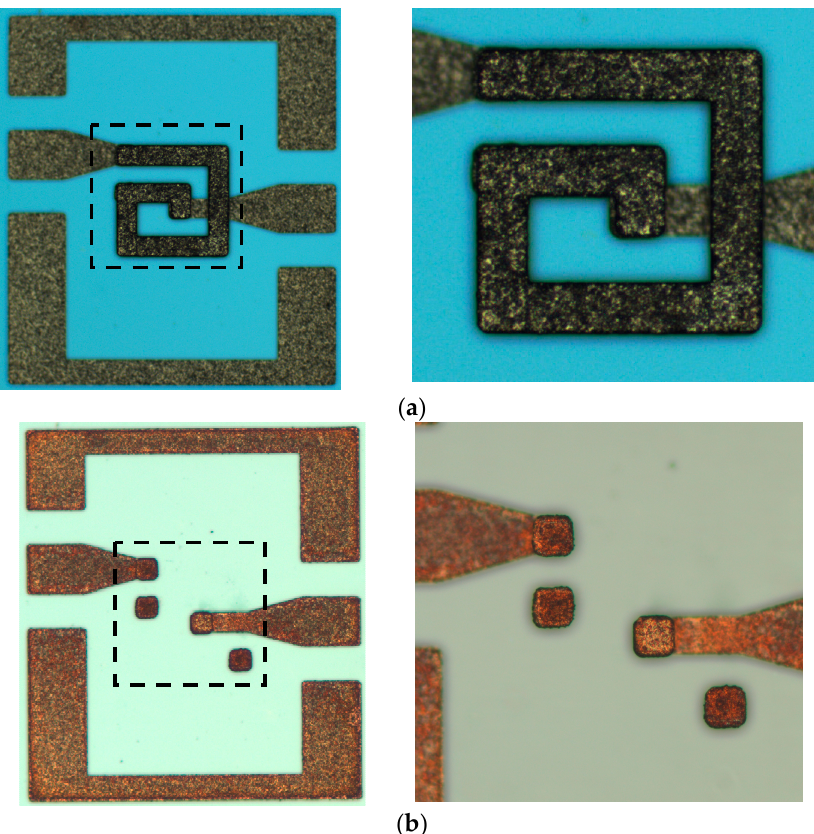
Figure 14. The failed inductor before and after 60,000 g shock test. ( a ) Before shock test; ( b ) after shock test.